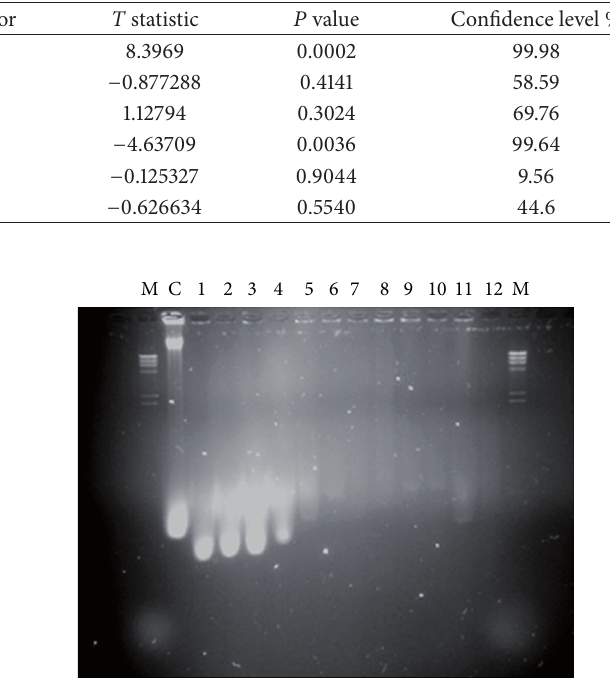
Figure 3: AGE for the marker (M), control (C), and twelve experiments